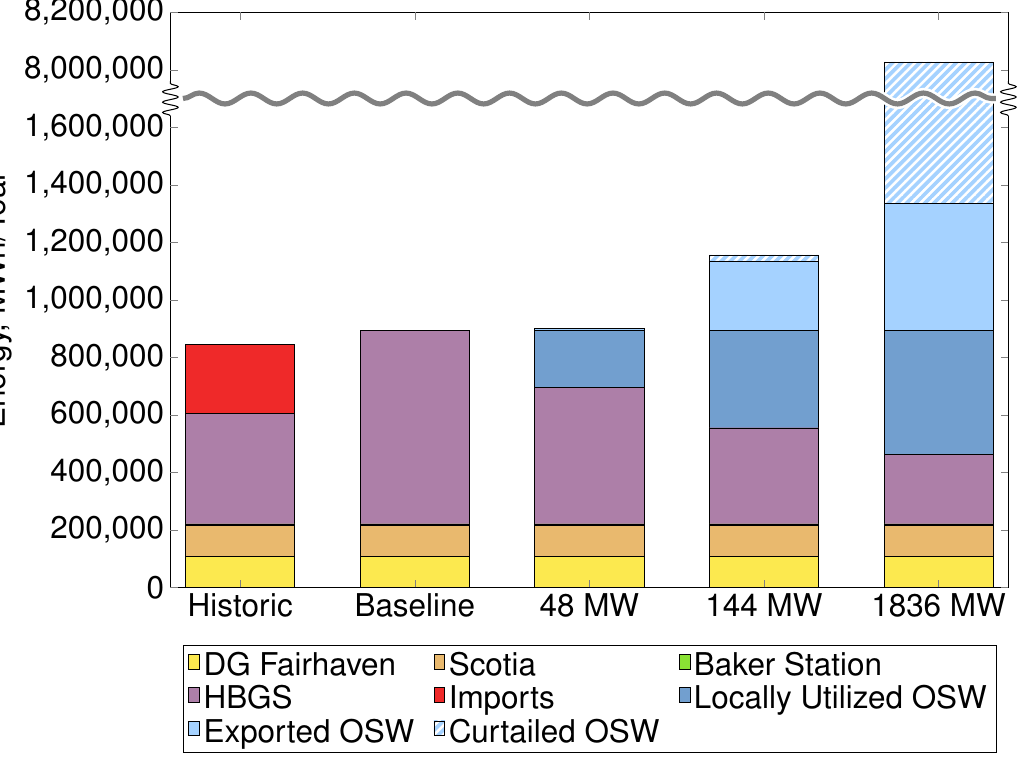
Figure 13. Annual energy generation by source for di ff erent levels of o ff shore wind development. Note the discontinuity in the vertical axis.